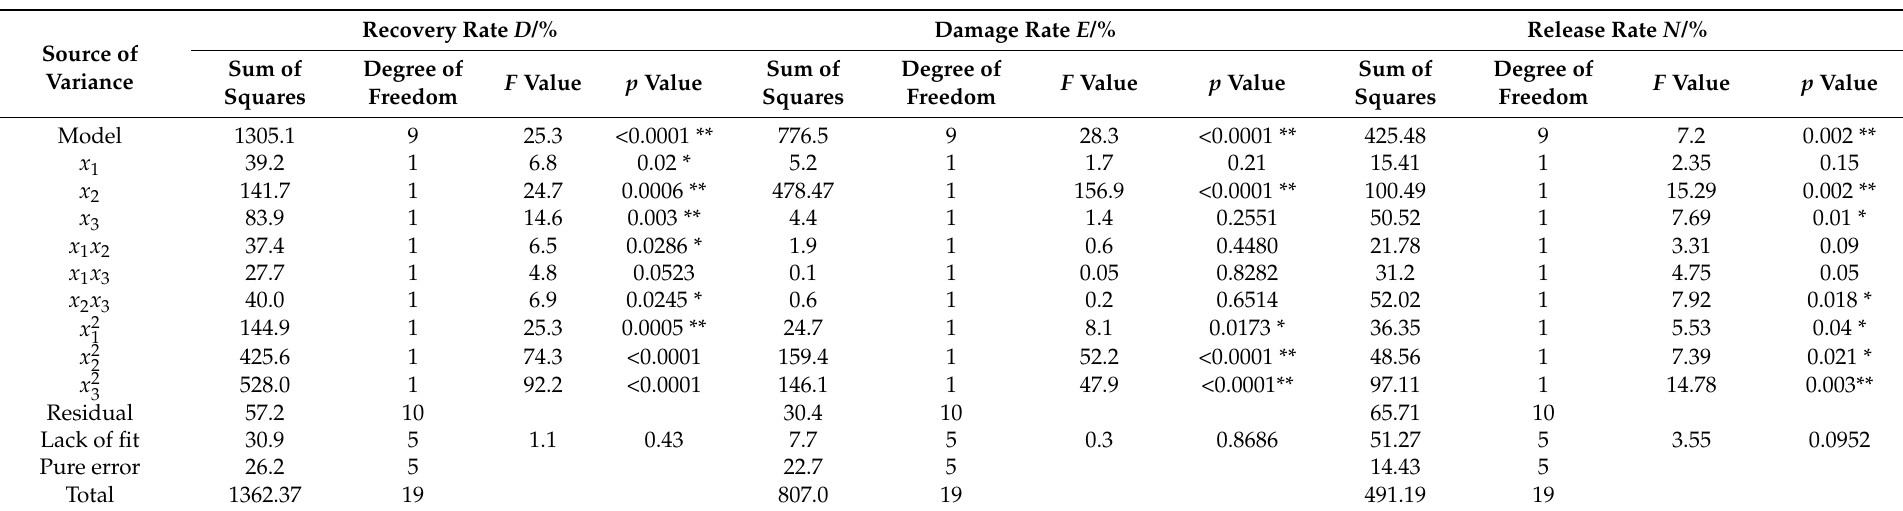
Table 5. Regression analysis of